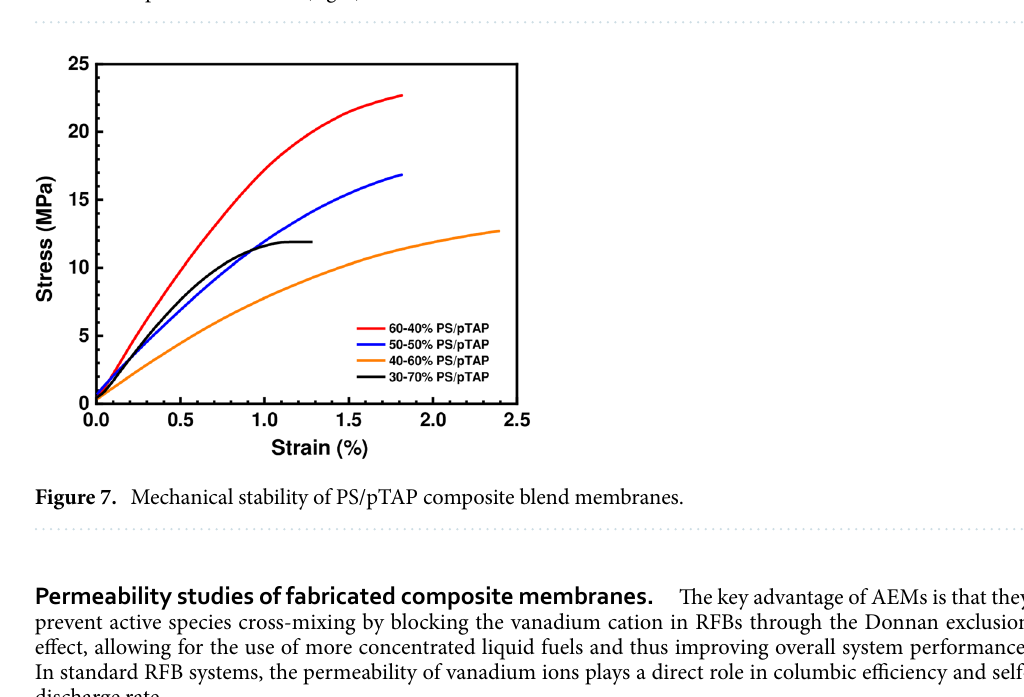
Figure 6. (a) Cyclic voltammogram for the crossover of vanadium through Nafion-212, and (b) PS/pTAP 40/60% composite membrane (right).